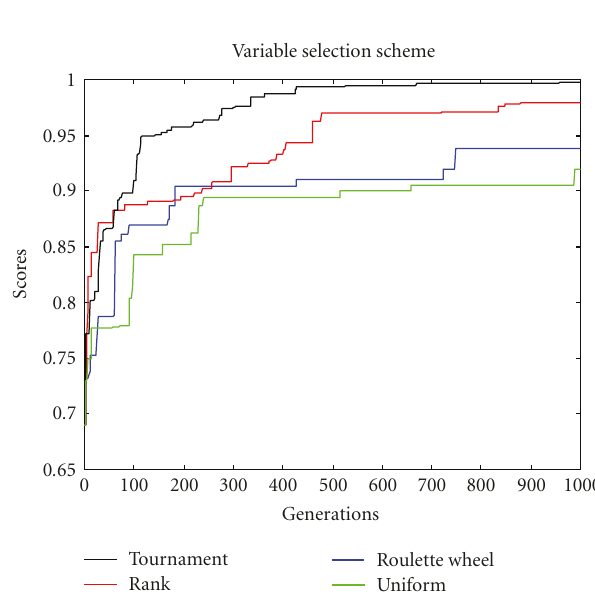
Figure 10: Fitness with sigma truncation.